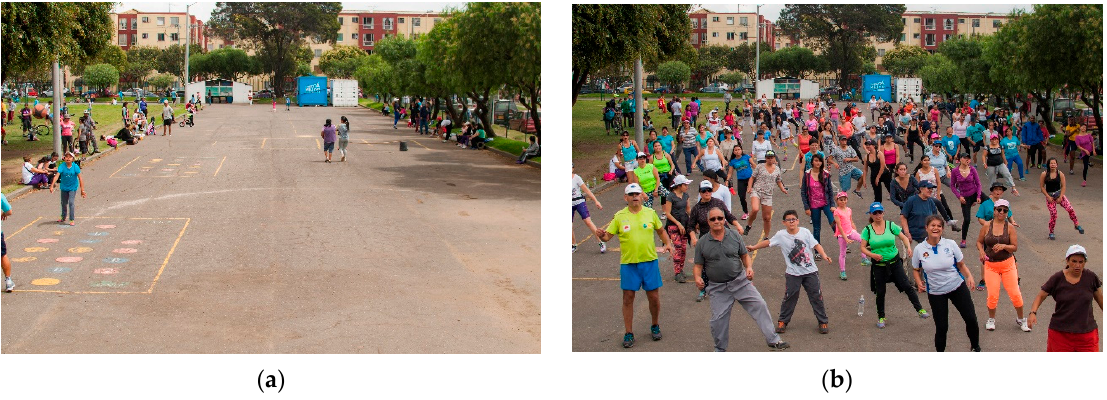
Figure 1. ( a ) Target area in a park without the Recreov í a program and; ( b ) The same park target area with the Recreov í a program. The park is located in a low-income neighborhood. Photo by Karoll